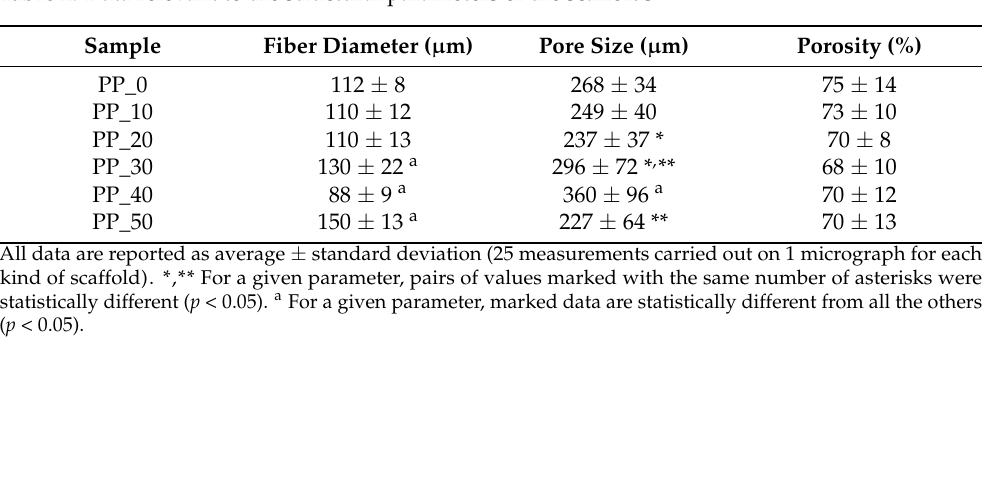
Table 2. Data relevant to the structural parameters of the